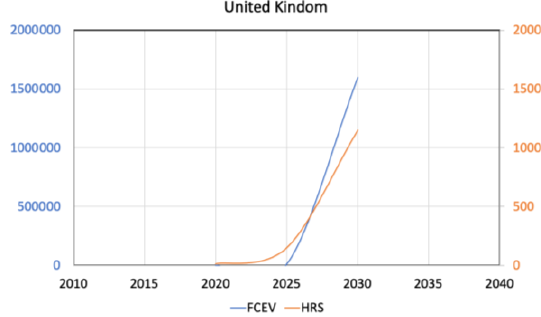
Fig. 7. The number of HRS and FCEVs in United Kindom